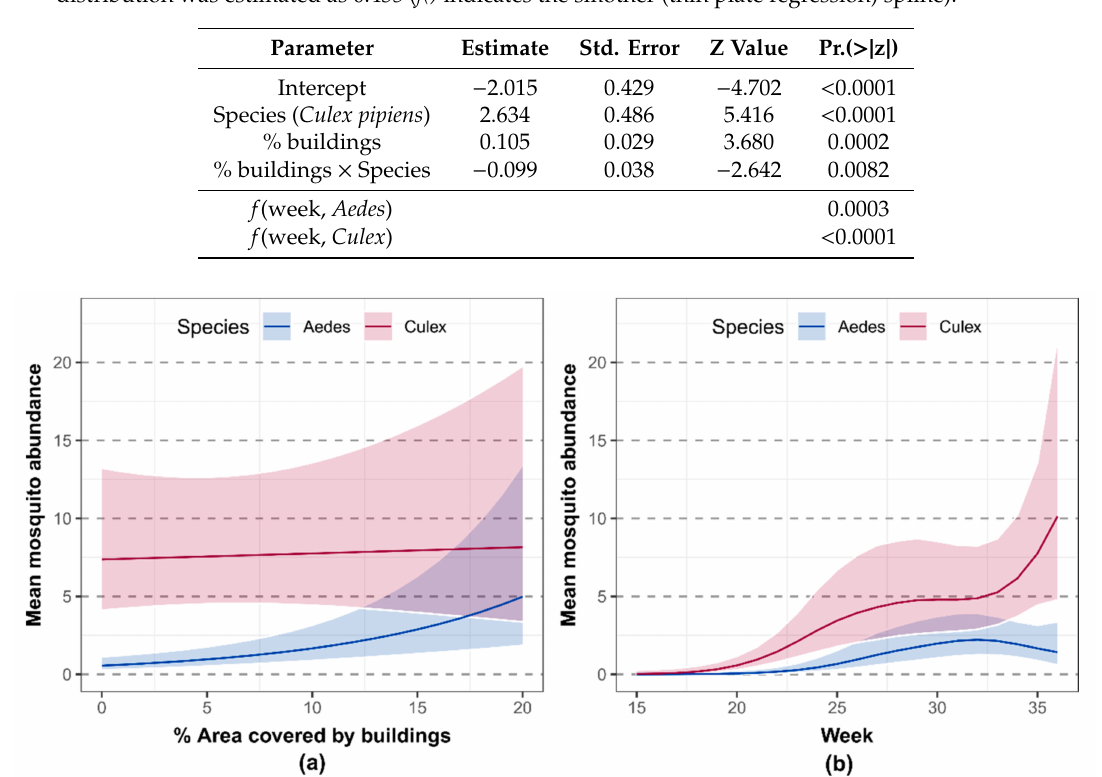
Figure 2. Results of the generalized additive model: ( a ) Relationship between the percentage of area covered by buildings (natural to urban gradient) and the mosquito abundance. The x-axis represents the percentage of area covered by buildings, and the y-axis represents the mosquito abundance. The solid line represents the average mosquito abundance, and the shaded areas are the 95% confidence intervals; ( b ) seasonal dynamics of mosquito abundance as estimated by the smoothers in the generalized additive model. The x-axis represents the week of the year, and the y-axis represents the mosquito abundance. The solid line represents the average mosquito abundance, and the shaded areas are the 95% confidence intervals. The average was computed assuming a 10% area covered by